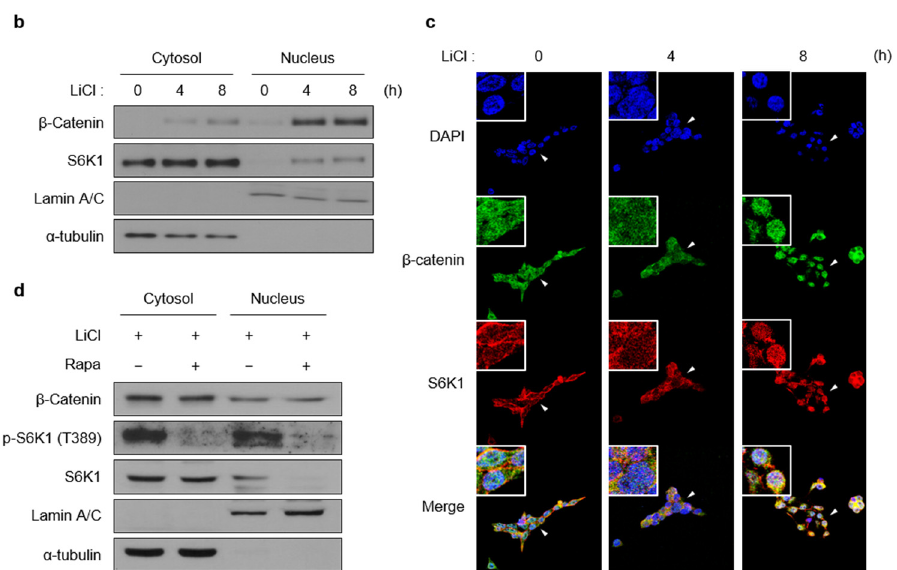
Figure 1. Wnt signaling pathway activates S6K1 and induces its translocation into the nucleus. ( a ) Wnt-3a and LiCl induce S6K1 phosphorylation. Cells (293T) were treated with Wnt-3a (300 ng/mL) and LiCl (25 mM) for the indicated time points. Immunoblotting was performed using specific antibodies as indicated. ( b , c ) LiCl promotes S6K1 nuclear translocation. Immunoblotting was performed using cytoplasmic and nuclear extracts from 293T cells treated with LiCl for the indicated time points ( b ). Localization of S6K1 and β -catenin was detected by immunostaining 293T cells treated with LiCl for the indicated time points ( c ). ( d ) Rapamycin inhibits Wnt-induced S6K1 nuclear translocation. Immunoblotting was performed using cytoplasmic and nuclear extracts from 293T cells treated with LiCl in the absence or presence of rapamycin (25 nM). Cells were pretreated with specific inhibitors for 1 h before LiCl treatment.